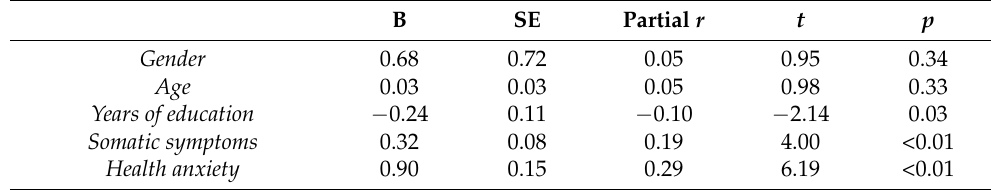
Table 3. Regression model predicting the severity of cyberchondria 3 .